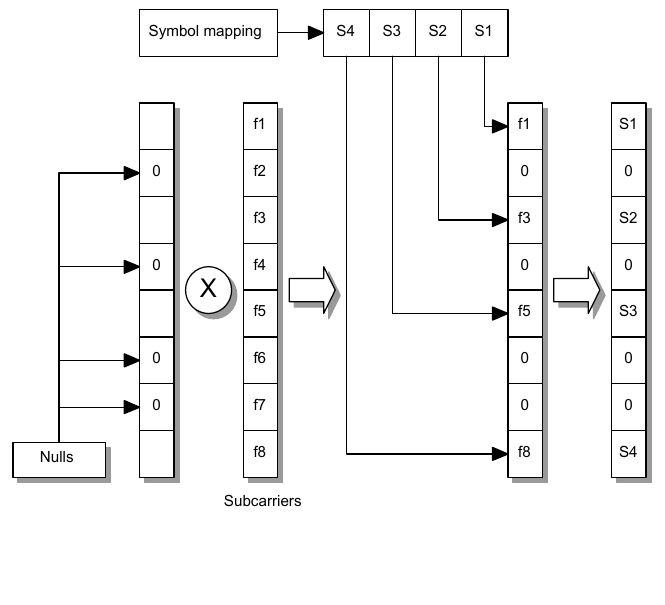
Figure 3. Selective Subcarrier Allocation (SSA) in